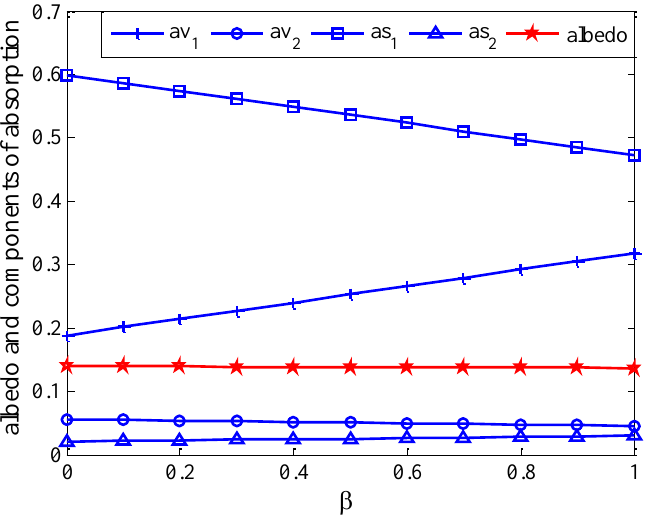
Figure 4. The determinants of the canopy albedo as a function of the fraction of diffuse  = 0.23 (at the green band).  LAI     and radiation. The base values include 3, 20 l s was varied from zero to one in steps of 0.1, while other parameters were held constant.